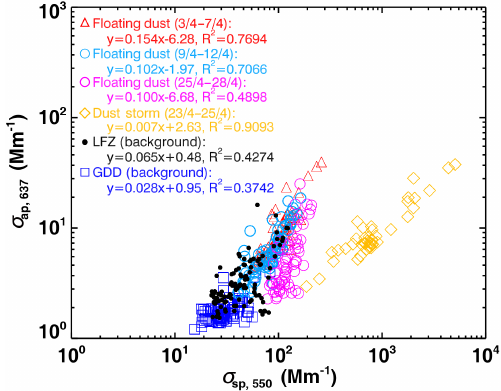
Figure 9. Scatter plots of (a) mass scattering efficiency (MSE) ver- sus single-scattering albedo at 637nm and (b) scattering Ångström exponent at 450–700nm versus aerosol scattering coefficient of PM 2 . 5 at 550nm. Panel (c) is the same as (b) but for PM 1 . 0 . The color symbols represent different atmospheric conditions during the dust field campaign.